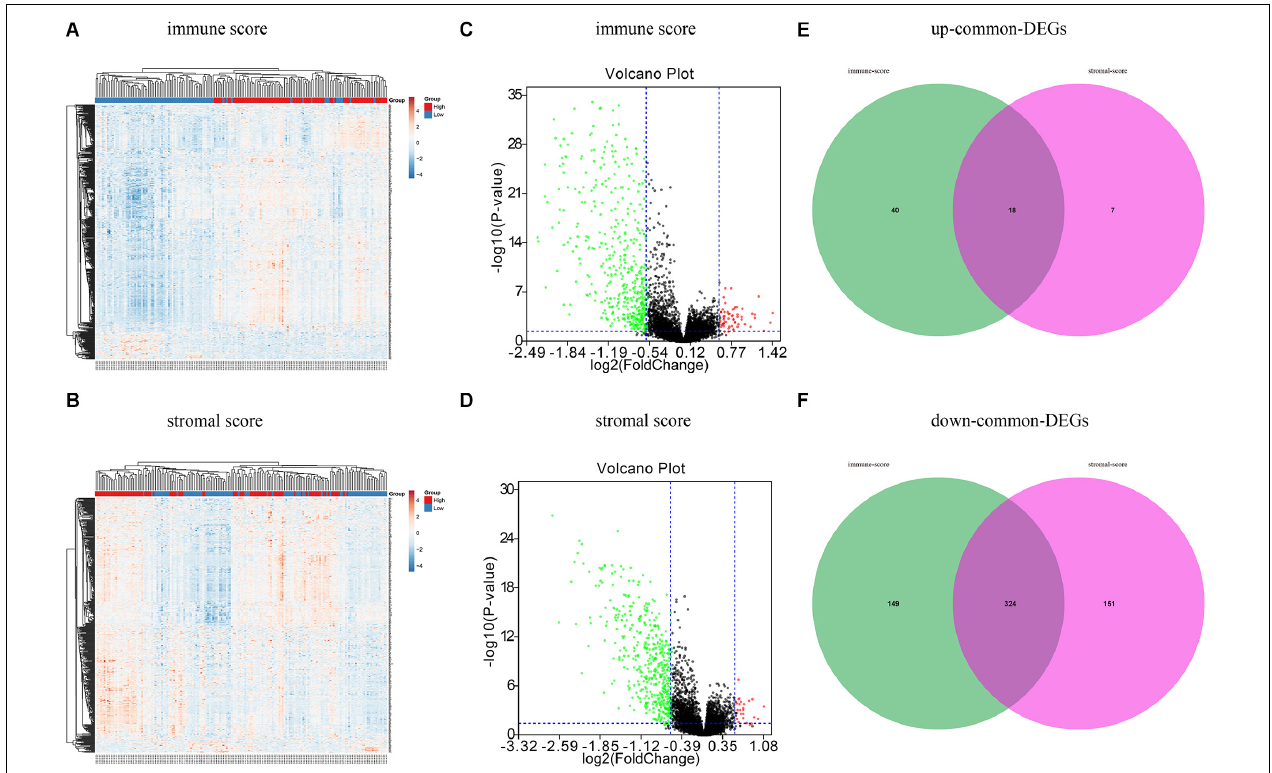
FIGURE 2 | Different expression genes based on immune scores and stromal scores in ovarian cancer. (A) Heat maps demonstrated the different expression genes (DEGs) between high immune scores low immune scores. P < 0.05, fold change > 1.5. (B) Heat map of DEGs between high stromal scores and low stromal scores. P < 0.05, fold change > 1.5. Red module represents high-expression genes; low-expression genes are shown in blue. (C) Volcano plot illustrated the DEGs based on immune scores. (D) Volcano plot displayed the DEGs based on stromal scores. Red dots represent upregulated genes, green dots represent downregulated genes. (E) Venn diagrams displayed the commonly upregulated genes in immune and stromal groups. (F) Venn diagrams showed the commonly downregulated